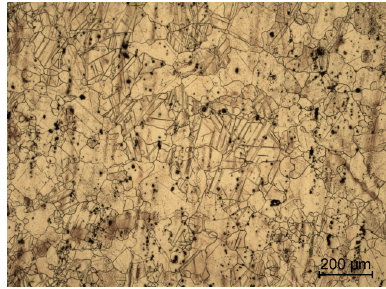
Figure 7. Microstructure of AZ31_RS after heat treatment up to 400 °C.